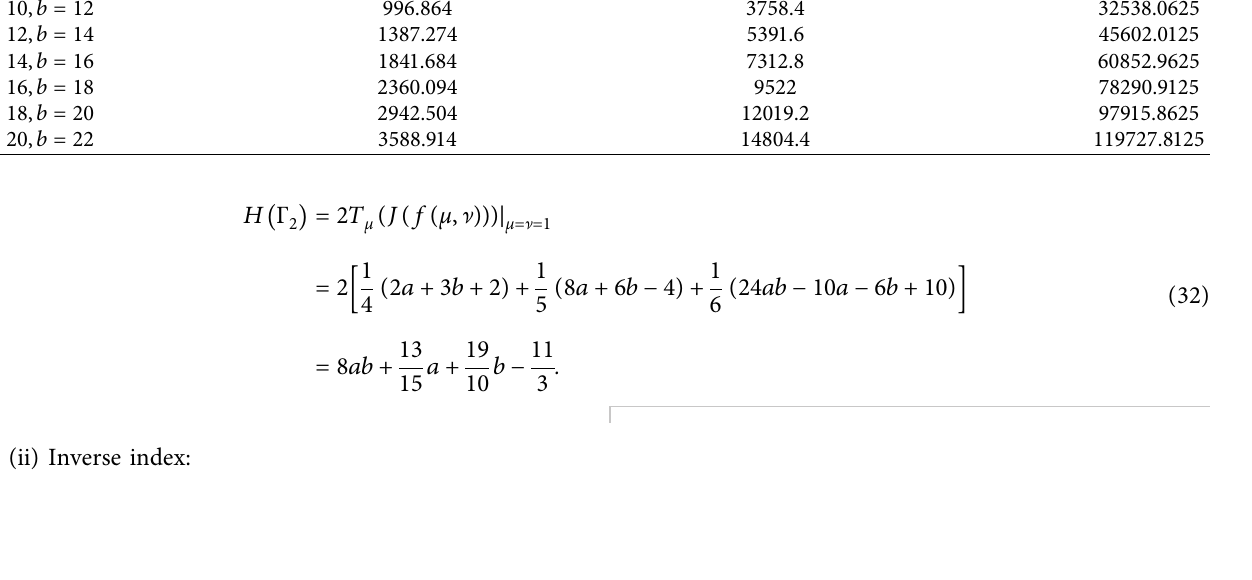
( Γ ) , and SDD ( Γ 1 2 ) , IS ( Γ 1